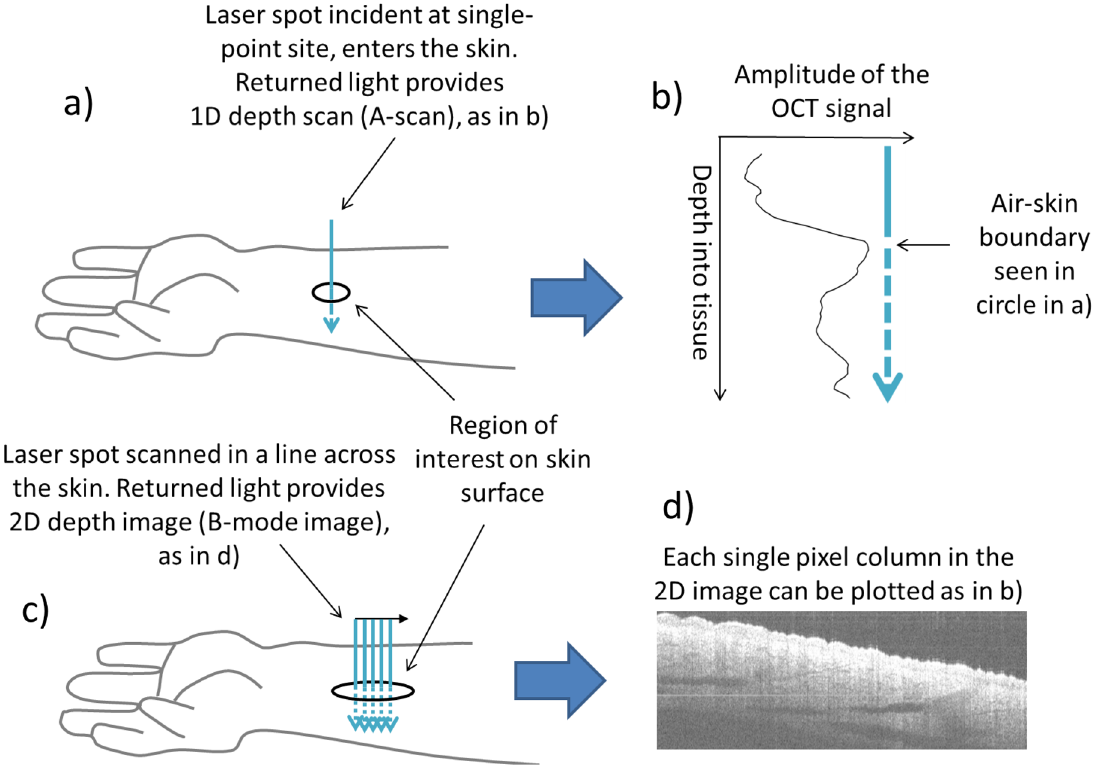
Figure 1. ( a , b ) Generation of single depth scans (A-scans). At each point an A-scan (a one-dimensional, single pixel scan into the depth of the tissue) is generated for both images (structural and retardance, here shown as the greyscale structural image). In the structural image this represents the relative amplitude of returned light (analogous to echo location in ultrasound) from each boundary encountered where refractive index changes of the tissues occur (observed as hyper- or hypo-reflective structures, i.e. peaks or troughs in the A-scan). For the retardance image the A-scan shows the relative change in birefringence with depth (birefringence induced